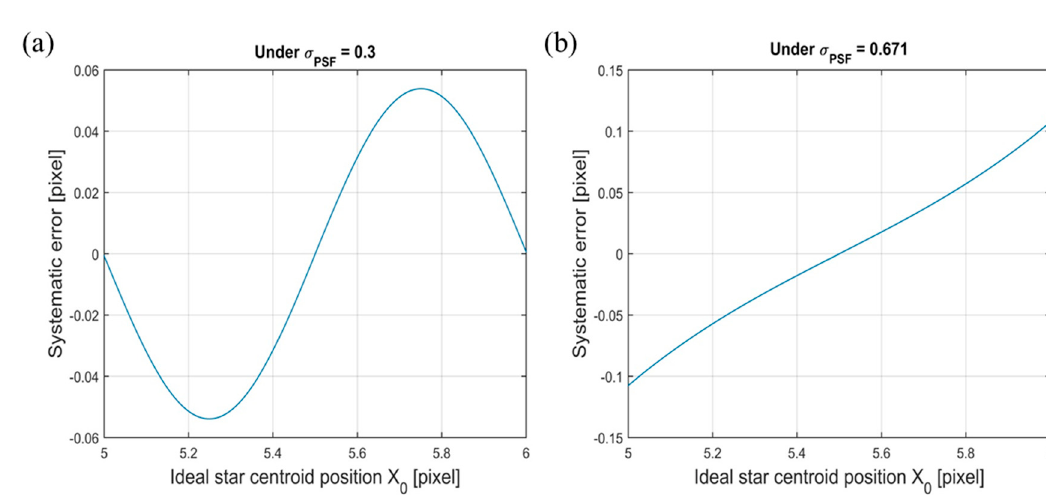
Figure 5. The relationship curve between σ ˆ x width σ PSF = 0.671.